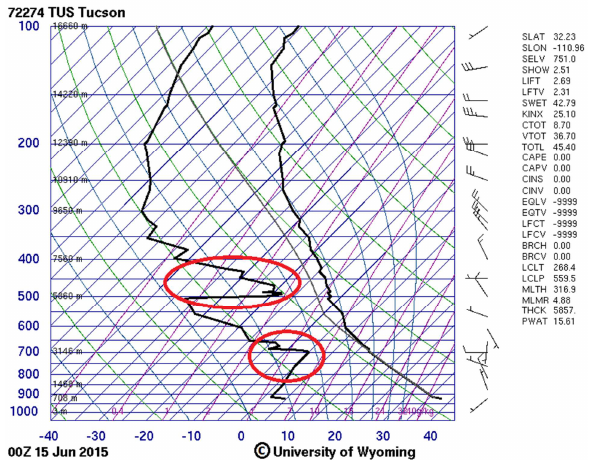
Figure 7. Emagram from Tucson AZ on June 15 2015, 00 UTC. There are two layers of humid air visible between 1000 m and 3100 m, and between 5900 m and 7500 m above ground